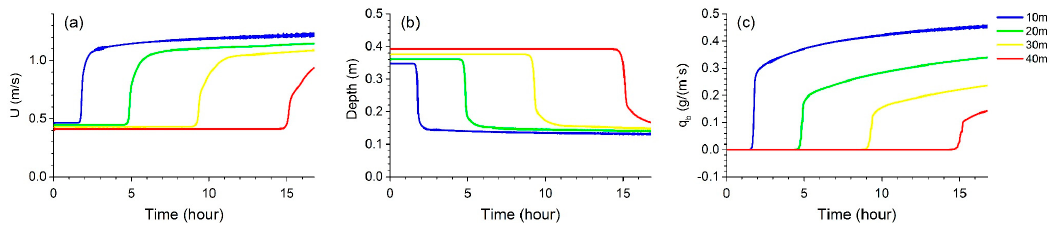
Figure 2. Model predicted ( a ) flow velocity; ( b ) water depth; and ( c ) bed load transport rate.